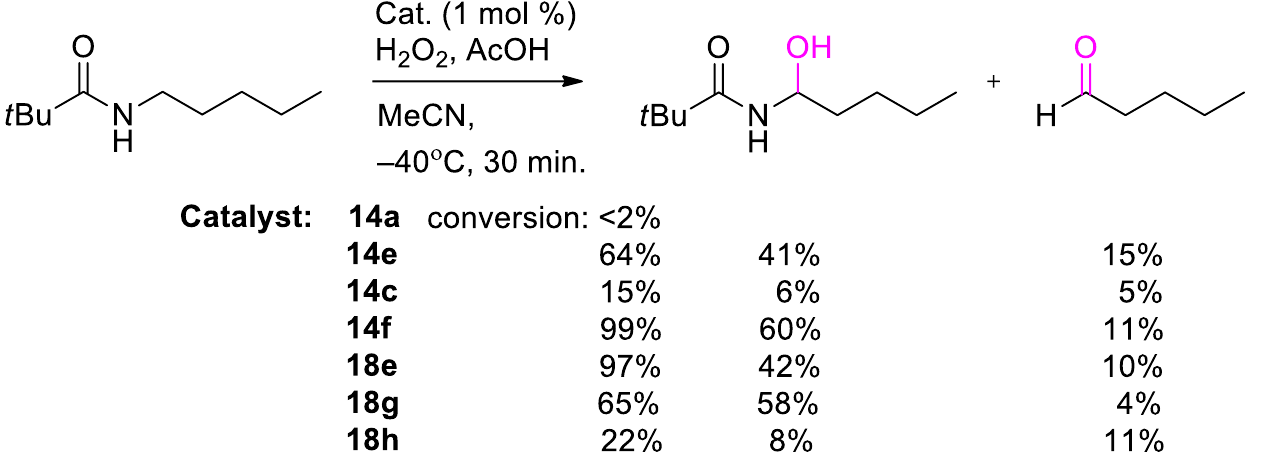
Figure 3. Structures of selected nonheme complexes.